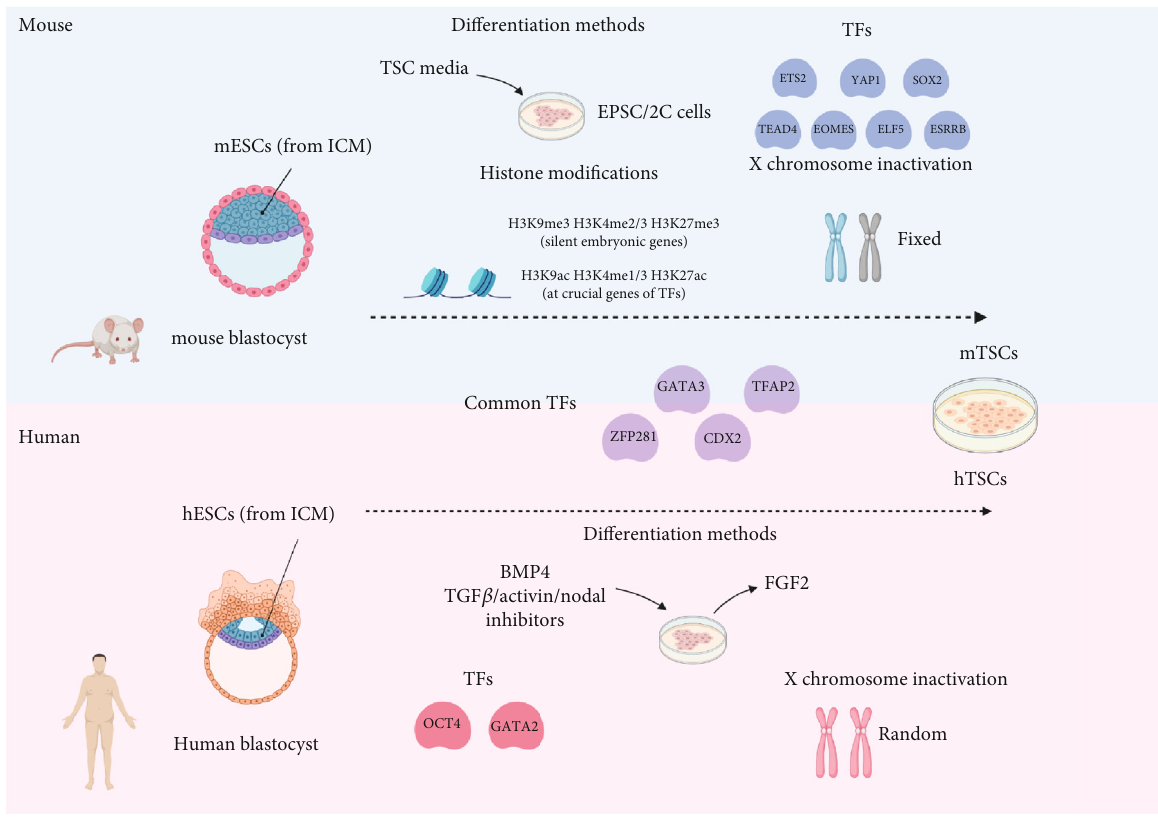
Figure 2: Summary of the comparison in deriving mouse and human ESCs and TSCs from mouse and human ESCs [10, 15, 57, 58, 65, 69 – 72, 75, 76, 82 – 85]. Created with